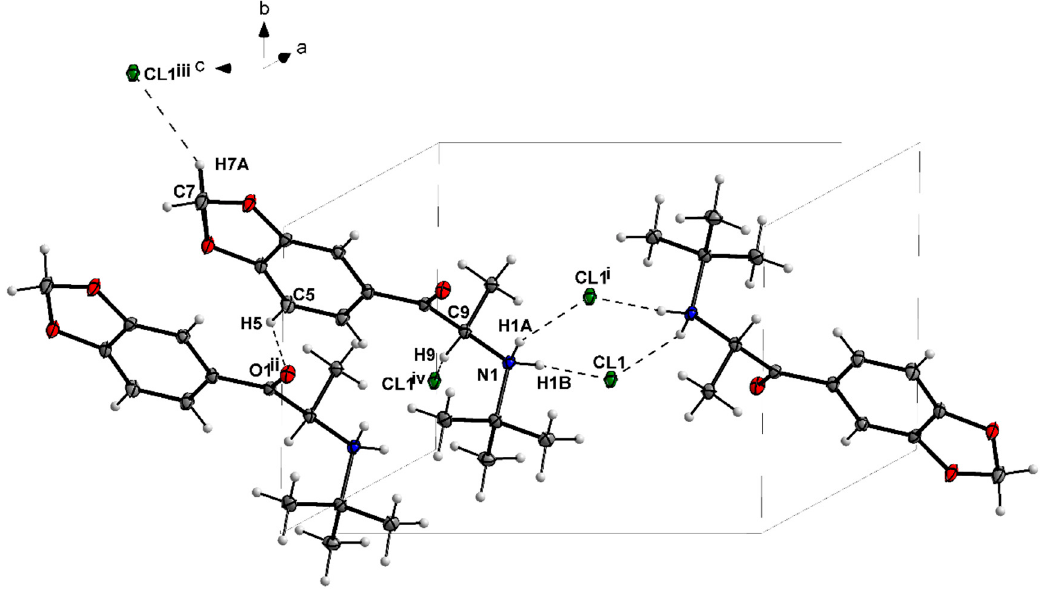
Figure 6. Part of the crystal structure of Compound 2 , showing H-bonding between neighboring ions